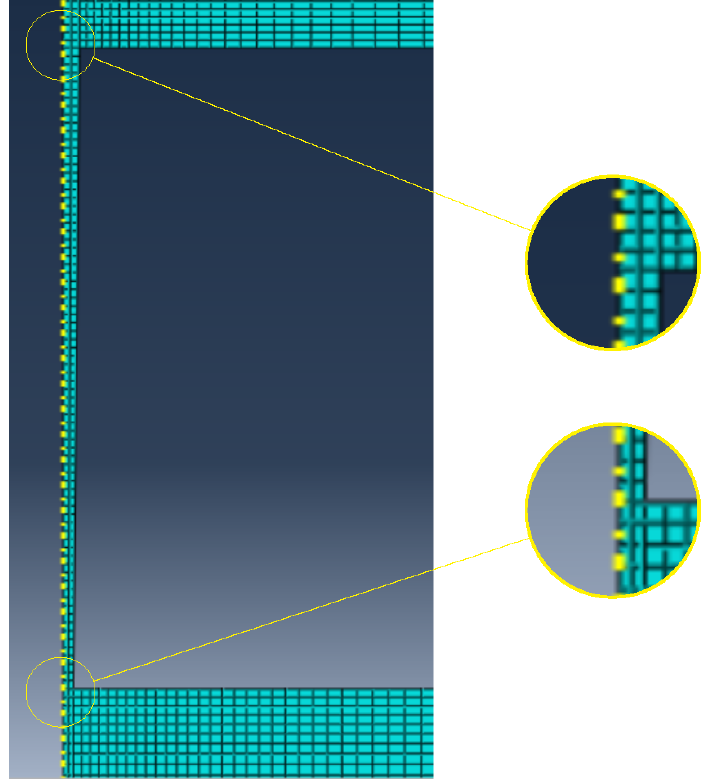
Figure 3. Mesh biased towards the